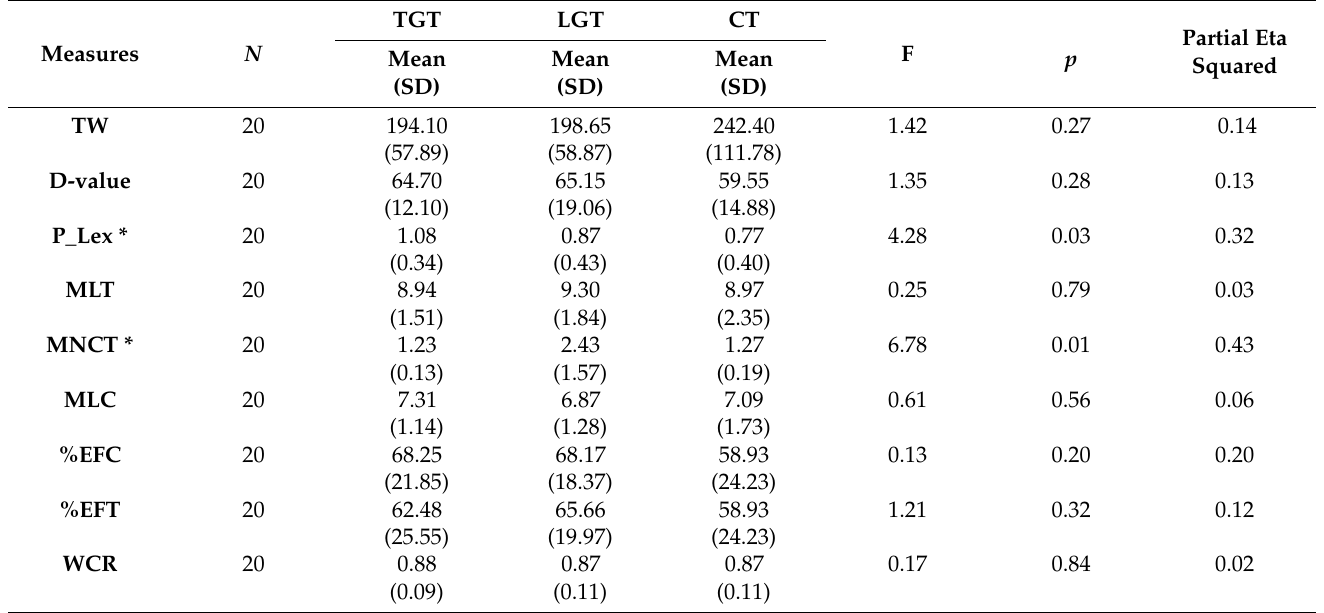
Table 1. Descriptive statistics and repeated measures ANOVA test results for Chinese students studying in Hungary